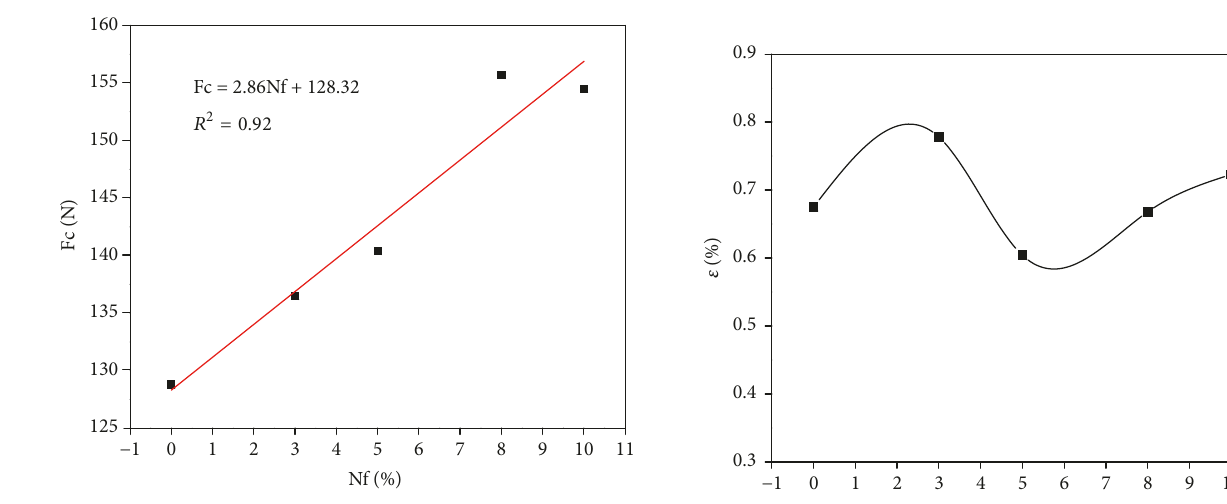
Figure 6: Plot of peak stress against CaCO 3 whisker. 𝐸 = 18.19 Nf −0.10 , (2)